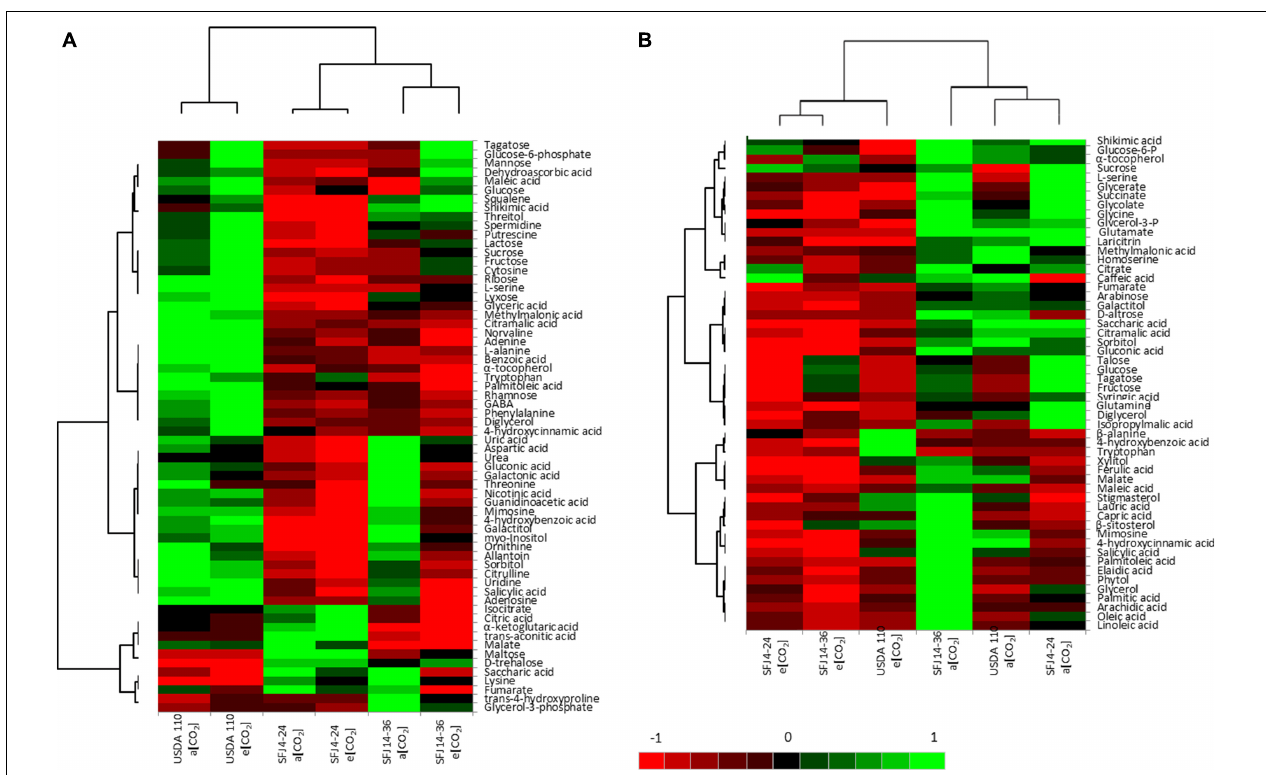
FIGURE 6 | Differentially expressed metabolites involved in [CO 2 ] responses in function of B. japonicum strain. (A) Hierarchically clustered heat maps of metabolites that were found to be significantly different between Bradyrhizobium strains, [CO 2 ], and their interaction in nodules. (B) Hierarchically clustered heat maps of metabolites that were found to be significantly different between Bradyrhizobium strains, [CO 2 ], and their interaction in leaves. Each column represents the average of three replicates. Intensity of red and green indicates increases and decreases relative to the mean respectively, as shown in the color